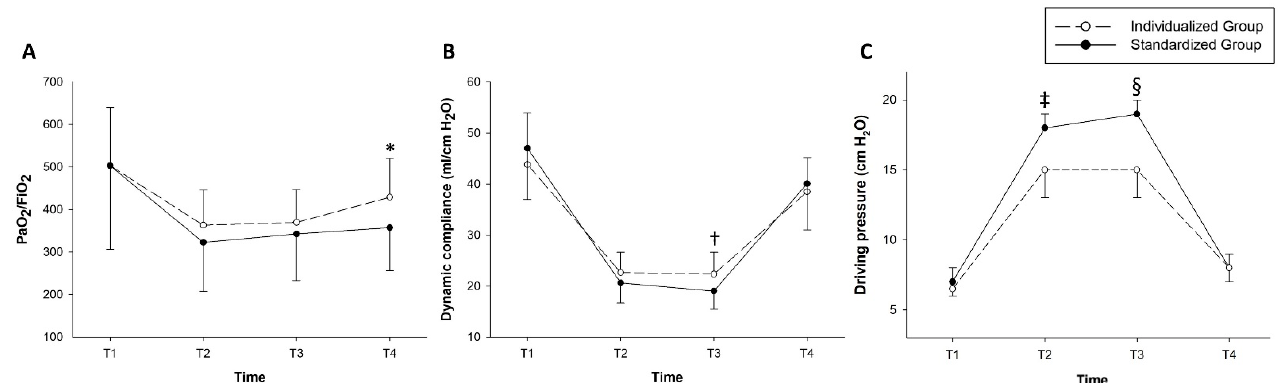
Figure 4. Intraoperative changes in the ventilator-related parameters. ( A ) shows arterial partial pressure of oxygen/fraction of inspired oxygen (PaO 2 /FiO 2 ), ( B ) shows dynamic respiratory compliance, and ( C ) shows driving pressure. *: p = 0.005, †: p = 0.002, and ‡: p = 0.004 and §: p < 0.001, respectively. Four time points were predefined for recording intraoperative ventilatory parameters and performing arterial blood gas analysis as follows: T1 = after anesthesia induction, T2 = after achieving the pneumoperitoneum under the steep Trendelenburg position, T3 = 1 h after T2, and T4 = just before extubation in the operating room.